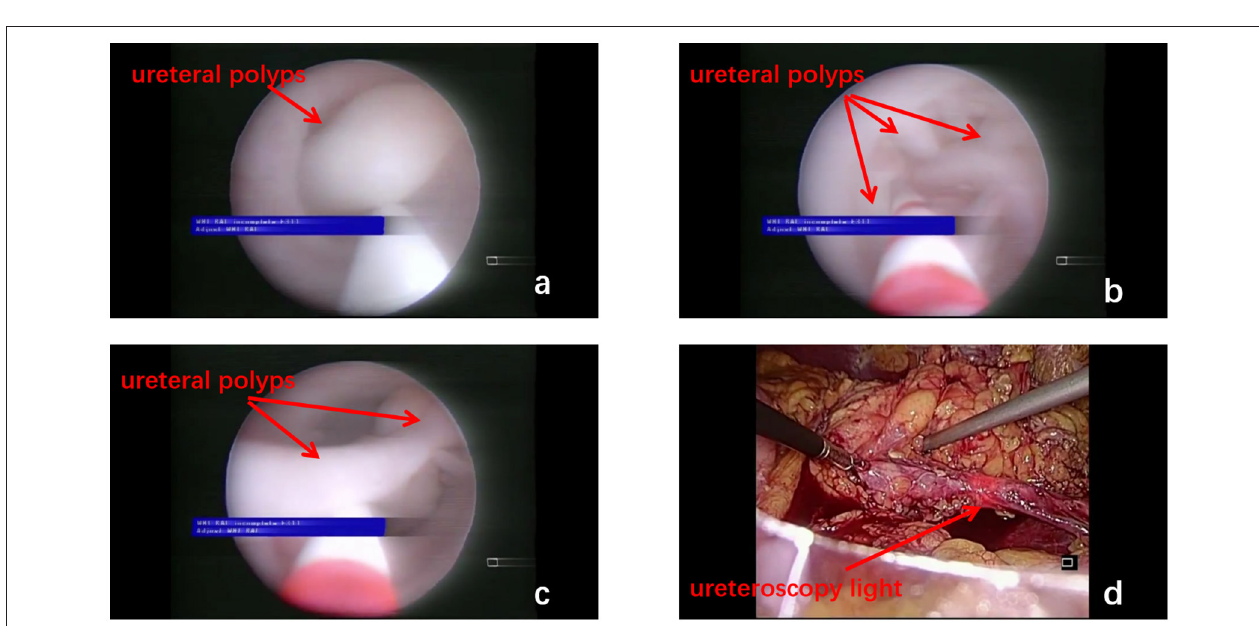
umbilicus with carbon dioxide to maintain the intra-abdominal pressure at 12–14 mmHg, as described by Tang et al. (12). A 12 mm trocar for the laparoscope was then placed through the incision. Under the guidance of the laparoscope, a second